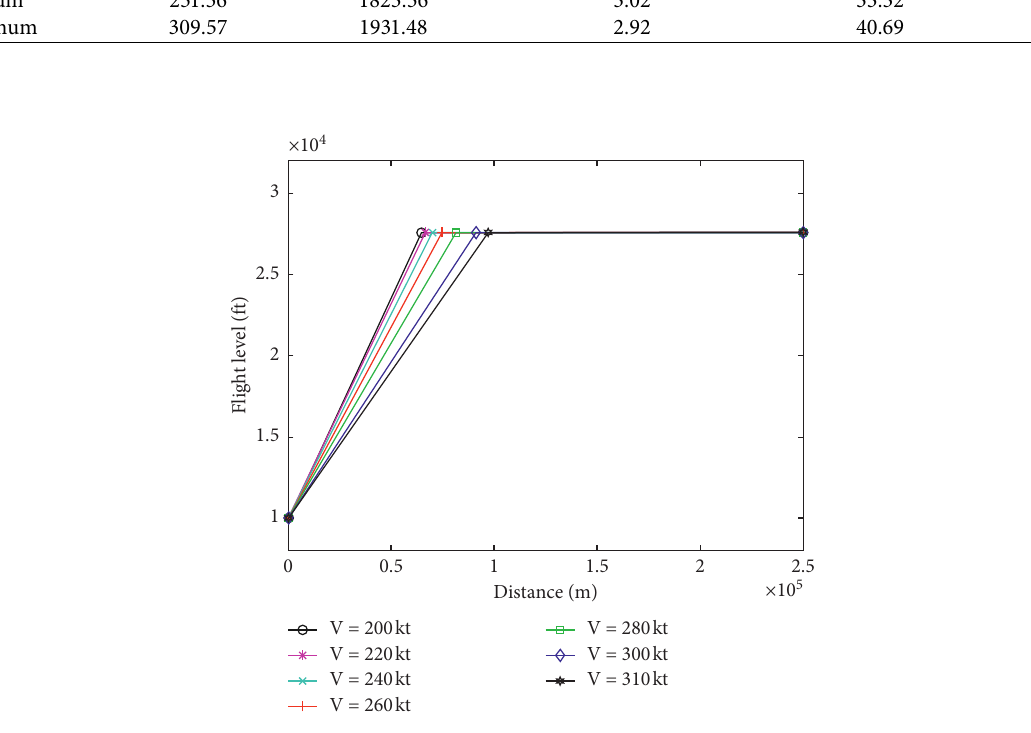
Figure 6: Trajectory for different